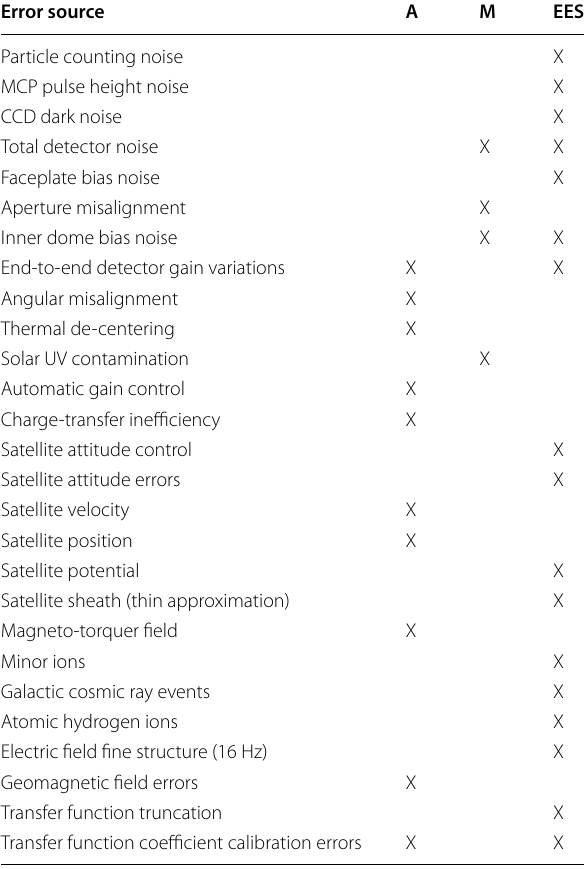
Table 1 Error sources and estimation methods. (EES) end-to-end simulation; (A) analysis; (M)